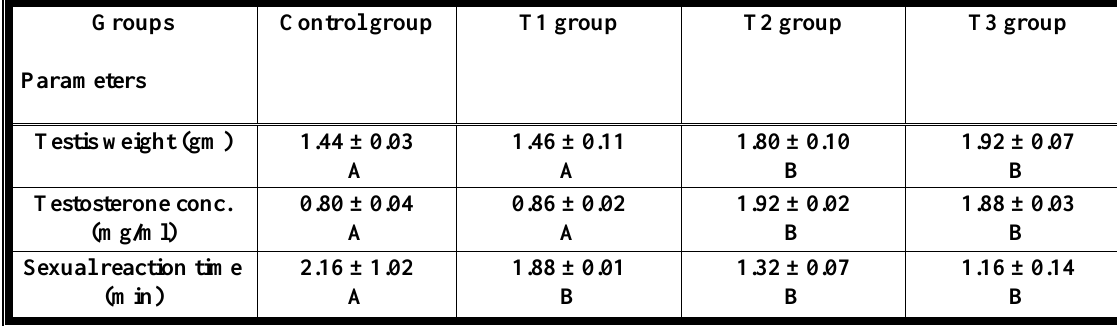
Table (1): Effect of date palm pollen (DPP) on testes weight , Testosteronelevel and sexual reaction time. ± S.E,n=10 rats